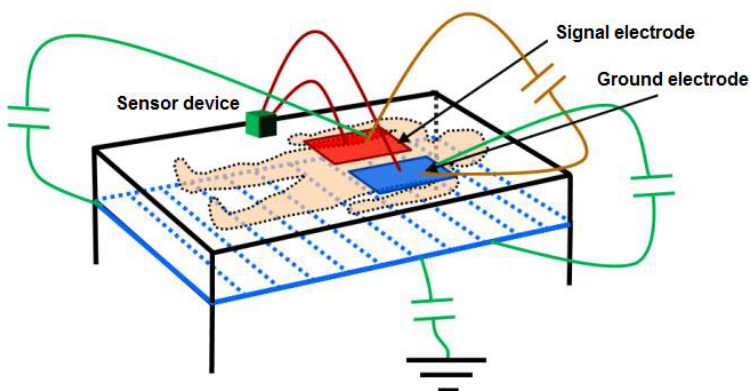
Figure 3. Proposed monitoring